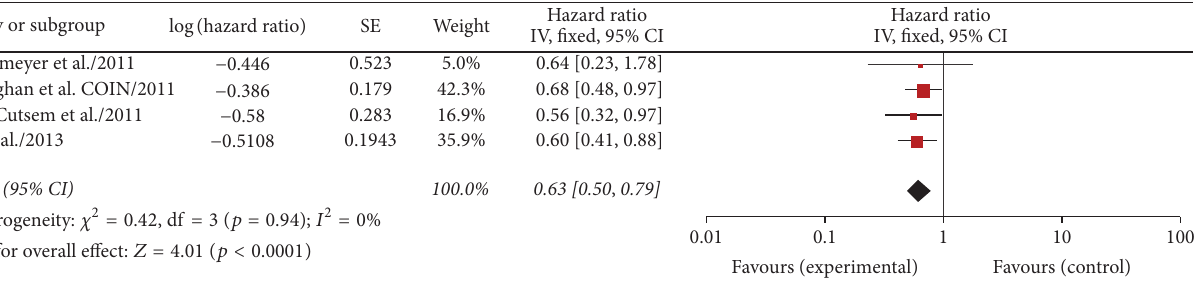
Figure 4: Meta-analysis PFS comparing chemotherapy ± cetuximab in patients with liver-limited metastases.